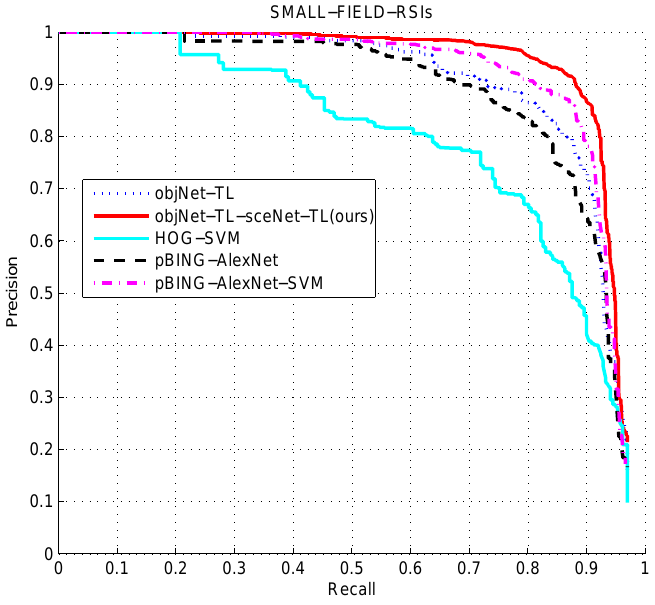
Figure 21. The performance comparison of different algorithms on the SMALL-FIELD-RSIs